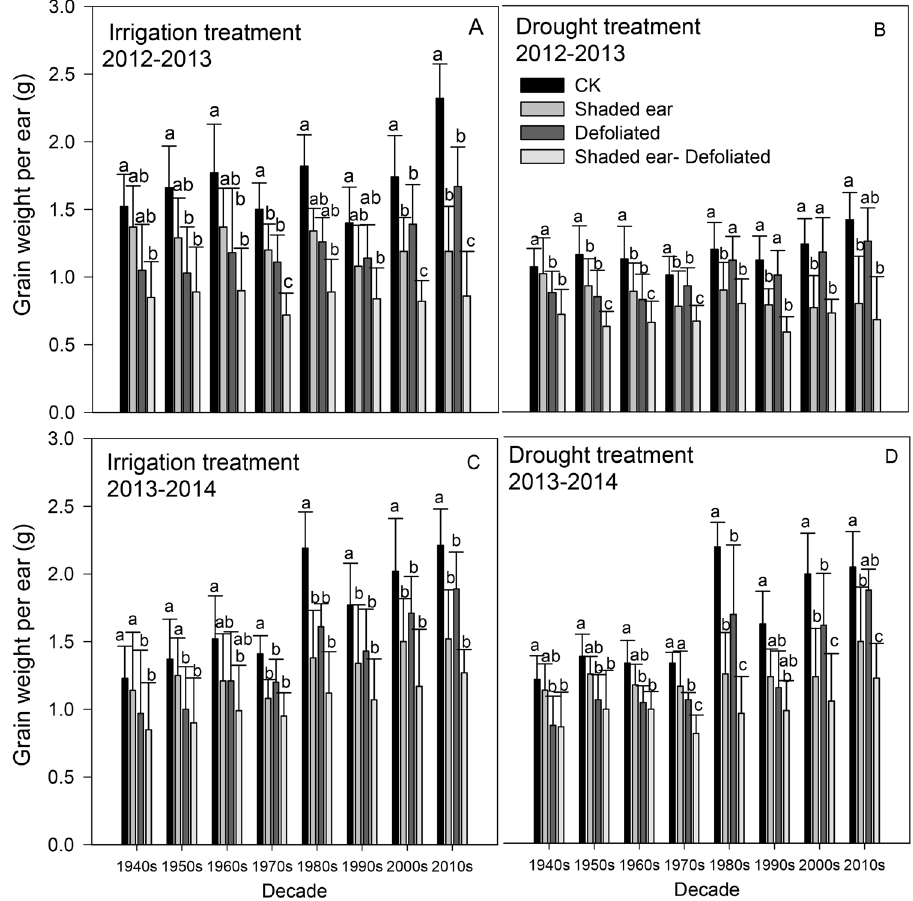
Figure 4. Shaded ear and defoliated influence on grain weight per ear (g) of different cultivars. The data represent the mean ± SE (N = 30). The different lowercase letters above the bars denote significant differences for the same cultivar under different defoliation or ear-shading treatments ( P <